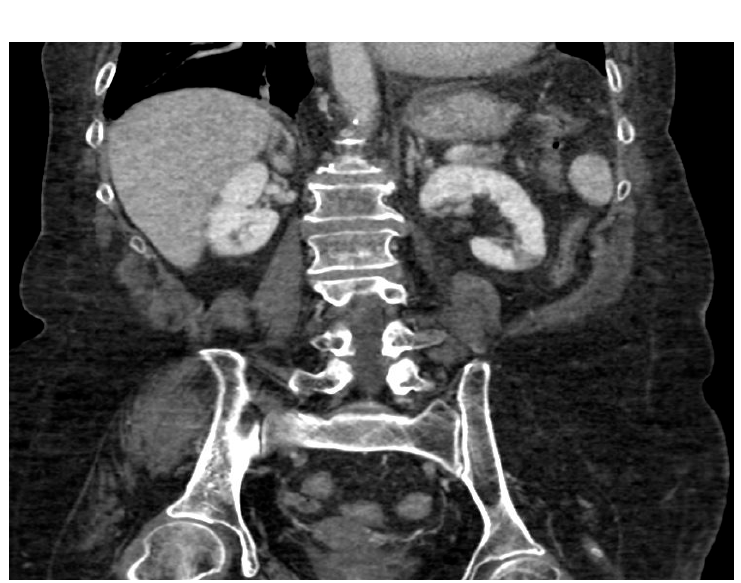
Figure 3. CT angiography, coronal planes, portal phase. Focal ischemia of the left renal parenchyma may be noted in the lower polar location.